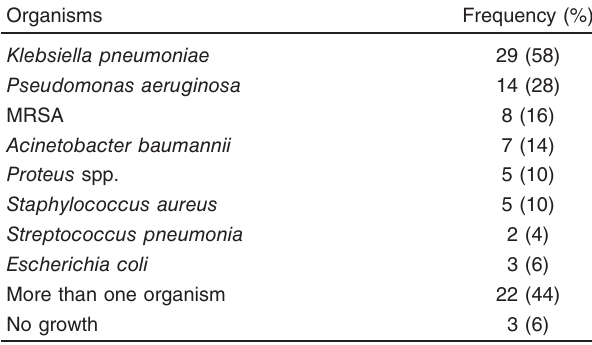
Table 2 Microbiological results of the 50 critically ill patients with chronic obstructive pulmonary disease admitted to respiratory intensive care unit